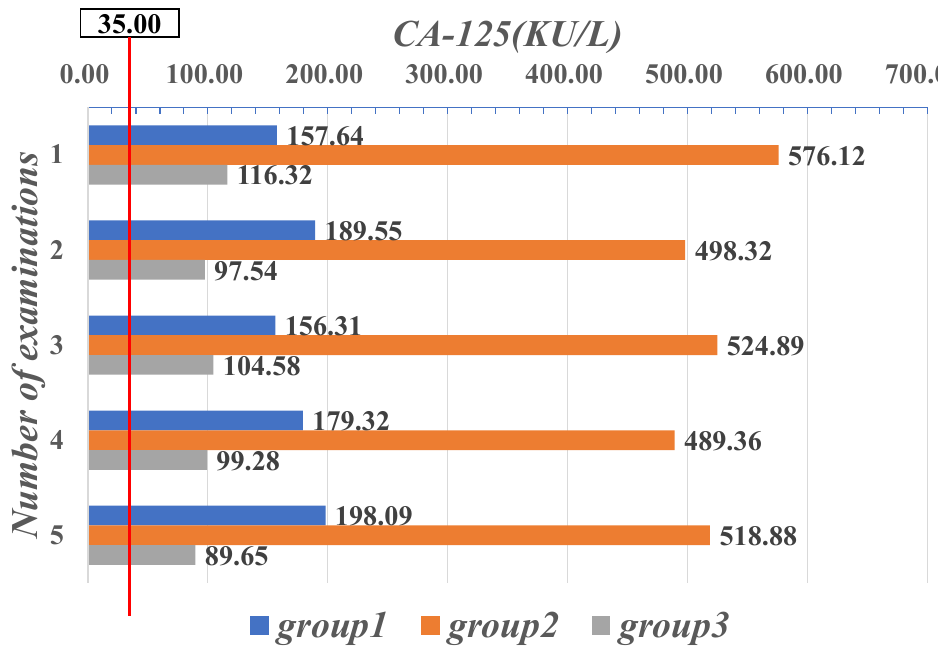
Figure 8. Mean value data of five CA-125 examinations in three groups of patients.